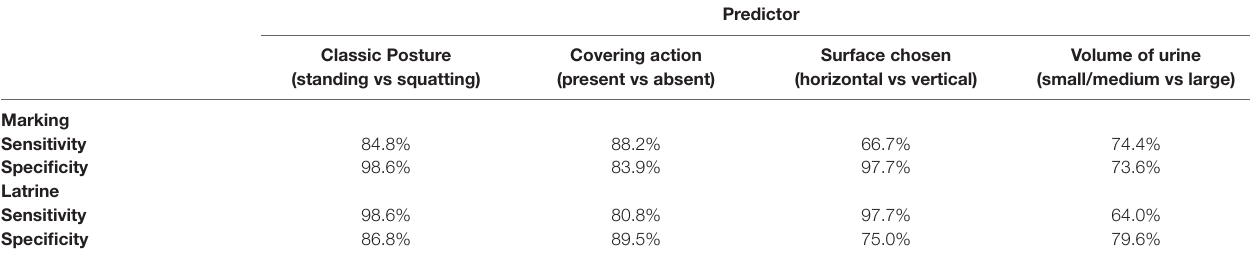
TaBle 6 | Sensitivity and specificity of the most significant predictors for urinary marking and latrine behaviour.